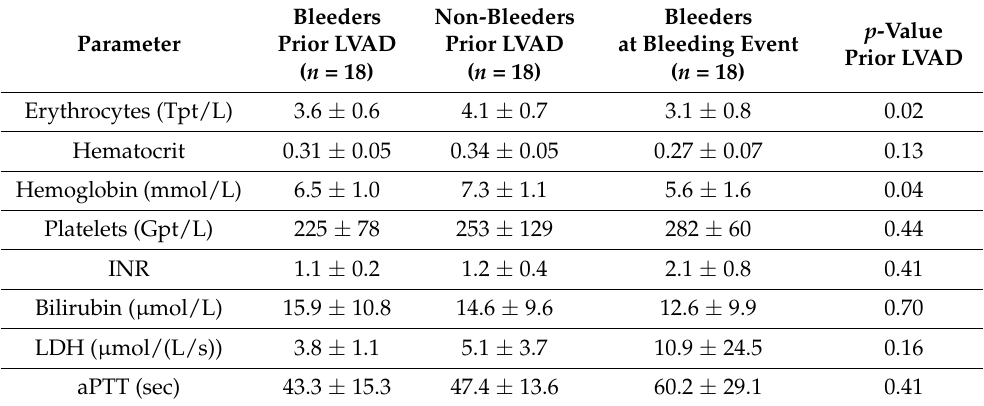
Table 4. Blood count parameters of bleeders and non-bleeders prior to LVAD implantation and at the timepoint of bleeding event.